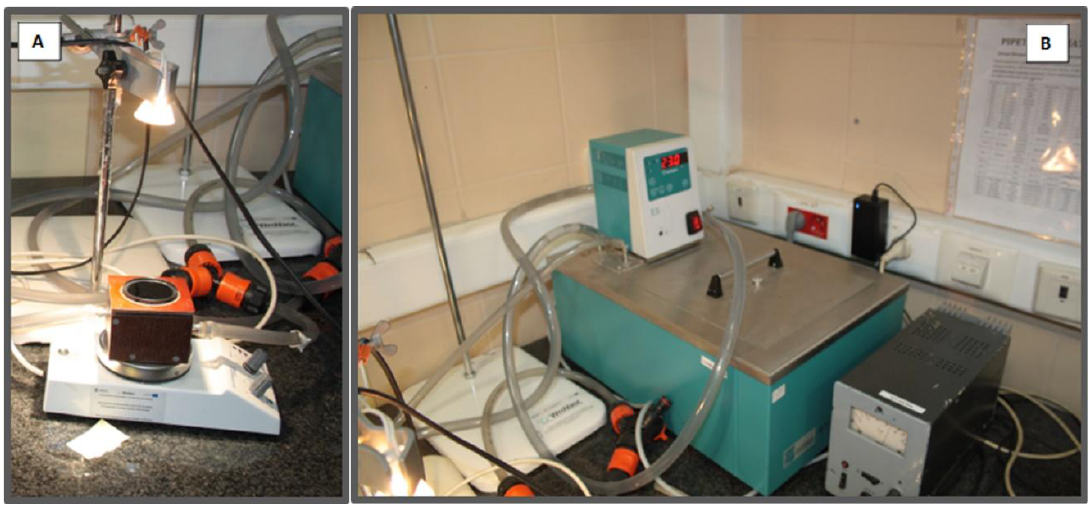
Figure 2: Experimental setup for NIR stimulation (A) and the cooling device (B); on the basis of Niemczyk (2017)